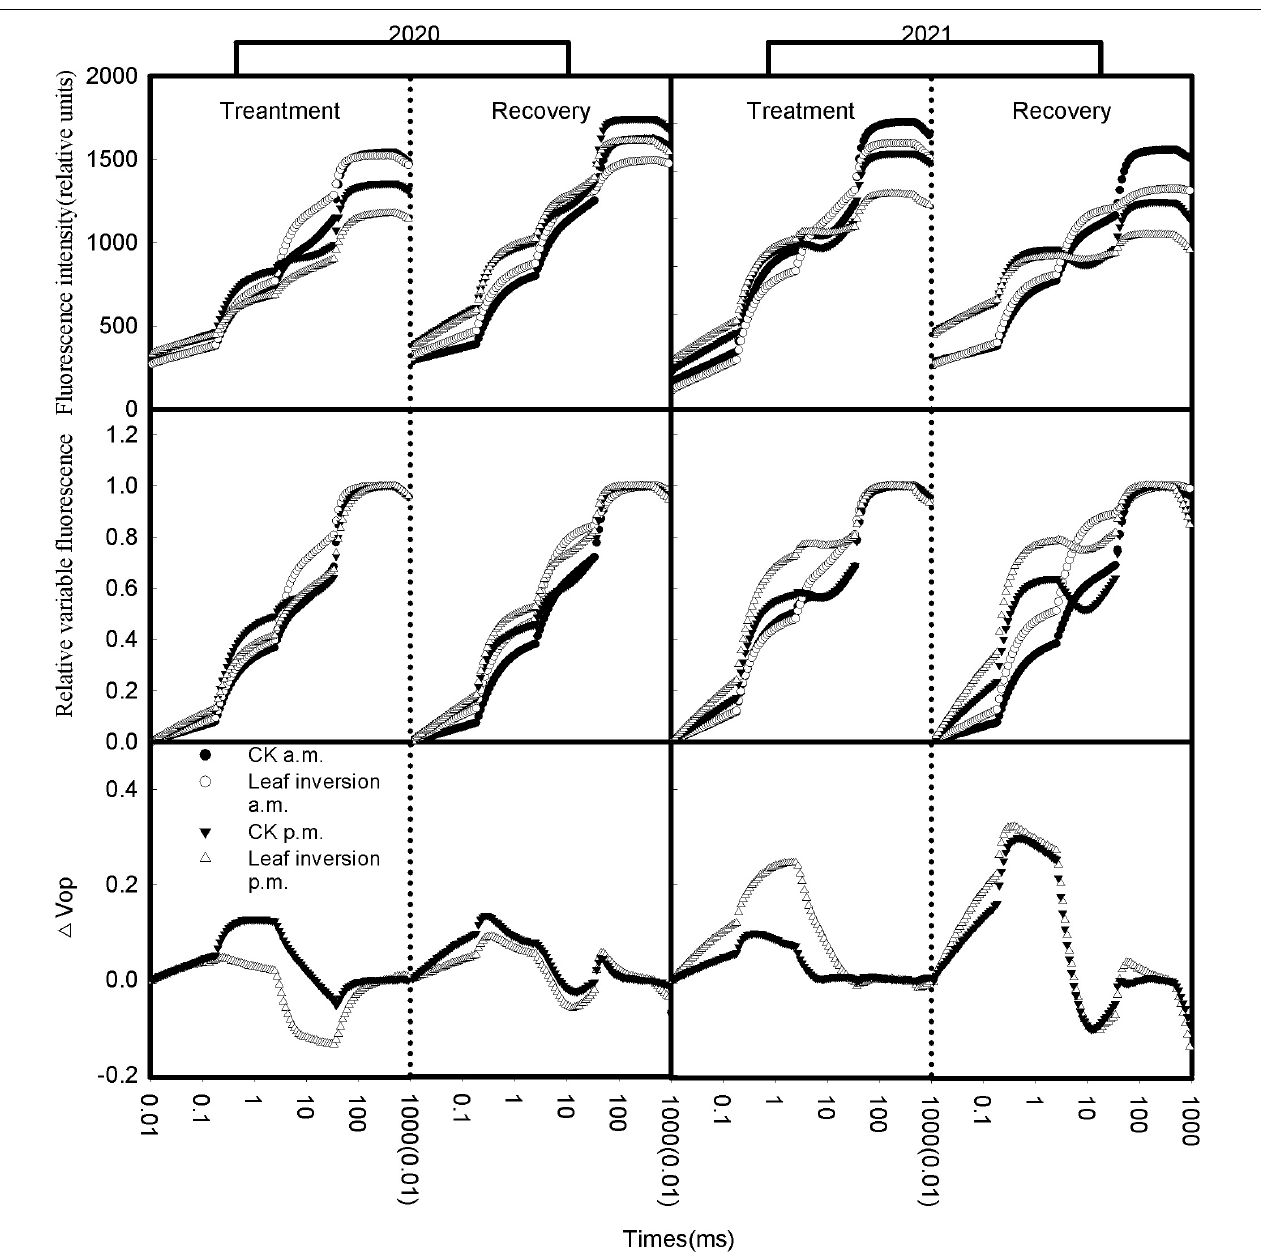
FIGURE 3 | Native fluorescence induction curves and double O–P normalized OJIP transients at 10 and 15 (recovery) days after soybean leaf inversion. Each curve presents the average kinetics of five repetitions. Chlorophyll a fluorescence transient curves normalized between F O and F P expressed as V OP [V OP = (F t –F O )/(F P –F O )], (cid:77) V OP = V OP (treatment at 4 p.m.) – V OP (measurement at 9 a.m.). The vertical dashed line separates treatment from recovery. The values in parentheses are the starting values for the graph on the